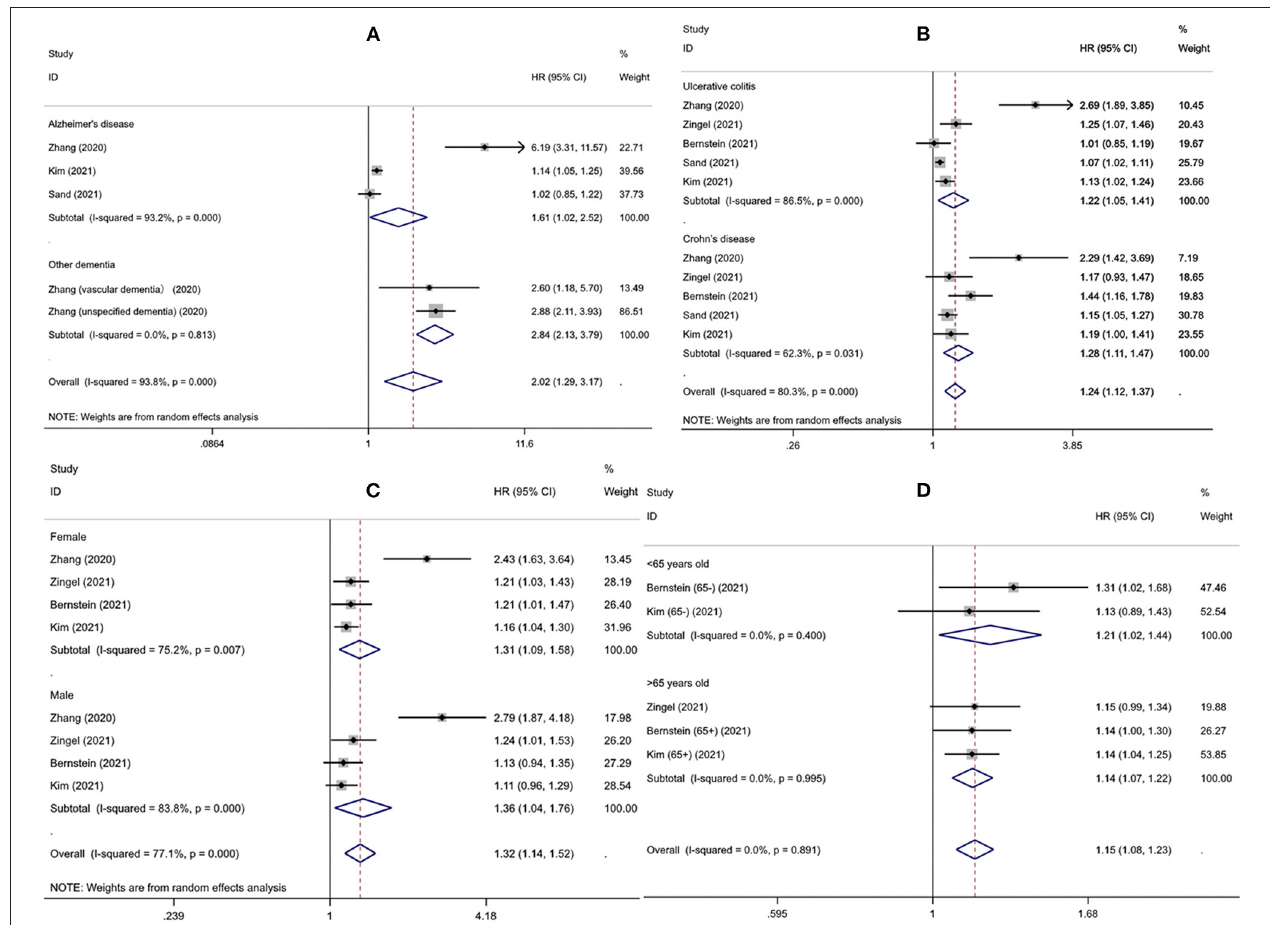
FIGURE 4 | The risk of developing dementia for different subgroups (A) dementia subtypes (B) inflammatory bowel disease subtypes (C) gender (D)